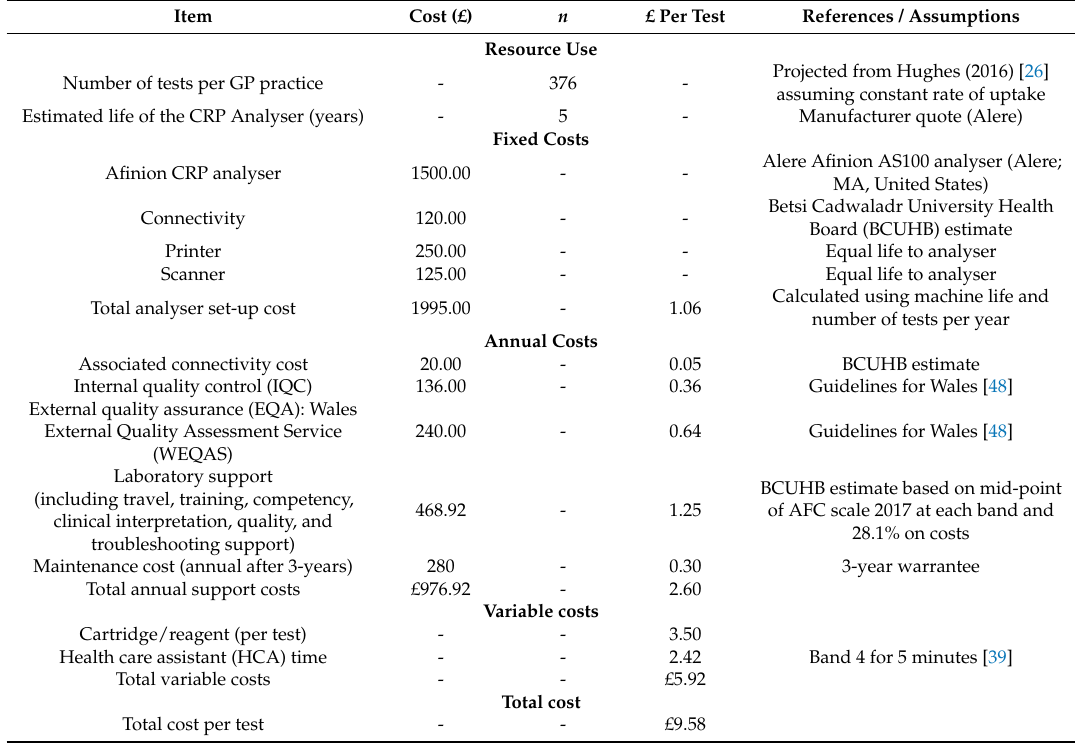
Table 4. Cost of point-of-care (POC) C-reactive protein (CRP) testing according to the CRP POC